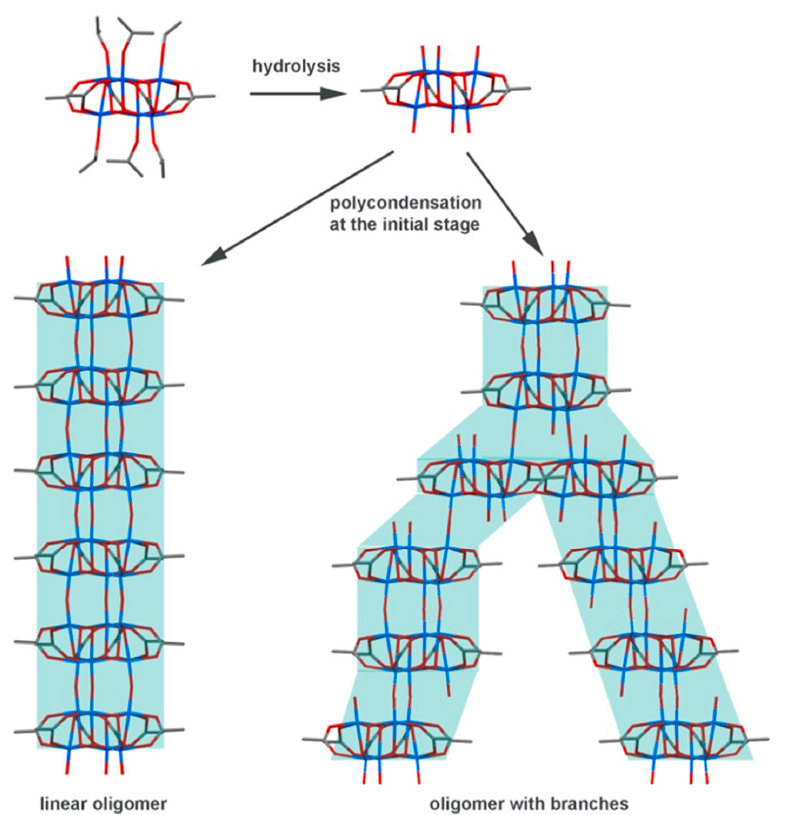
Figure 8. Hydrolysis and polycondensation of Ti 6 O 6 (OAc) 6 (O i Pr) 6 can form linear or branched oligomers at the initial stage of sol ‒ gel reactions. These oligomers may grow into agglomerated 1D and dendritic nanostructures in scCO 2 . Note: Ti = blue; O = red; C = dark gray; H atoms omitted for clarity.